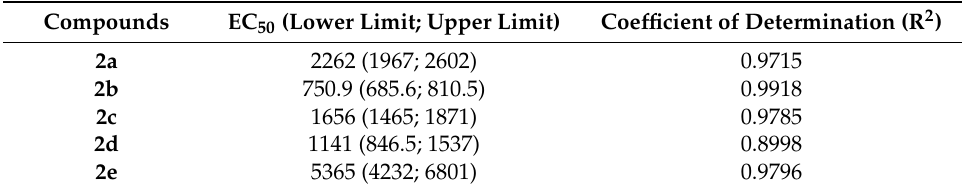
Table 1. Microtox ® EC 50 values (mg/kg of soil dry weight) of exposure of the luminescent marine bacteria Aliivibrio fischeri to tested aminophosphonates 2a – e with, respectively, 95% confidence limits (in brackets) obtained in the fit of the data.